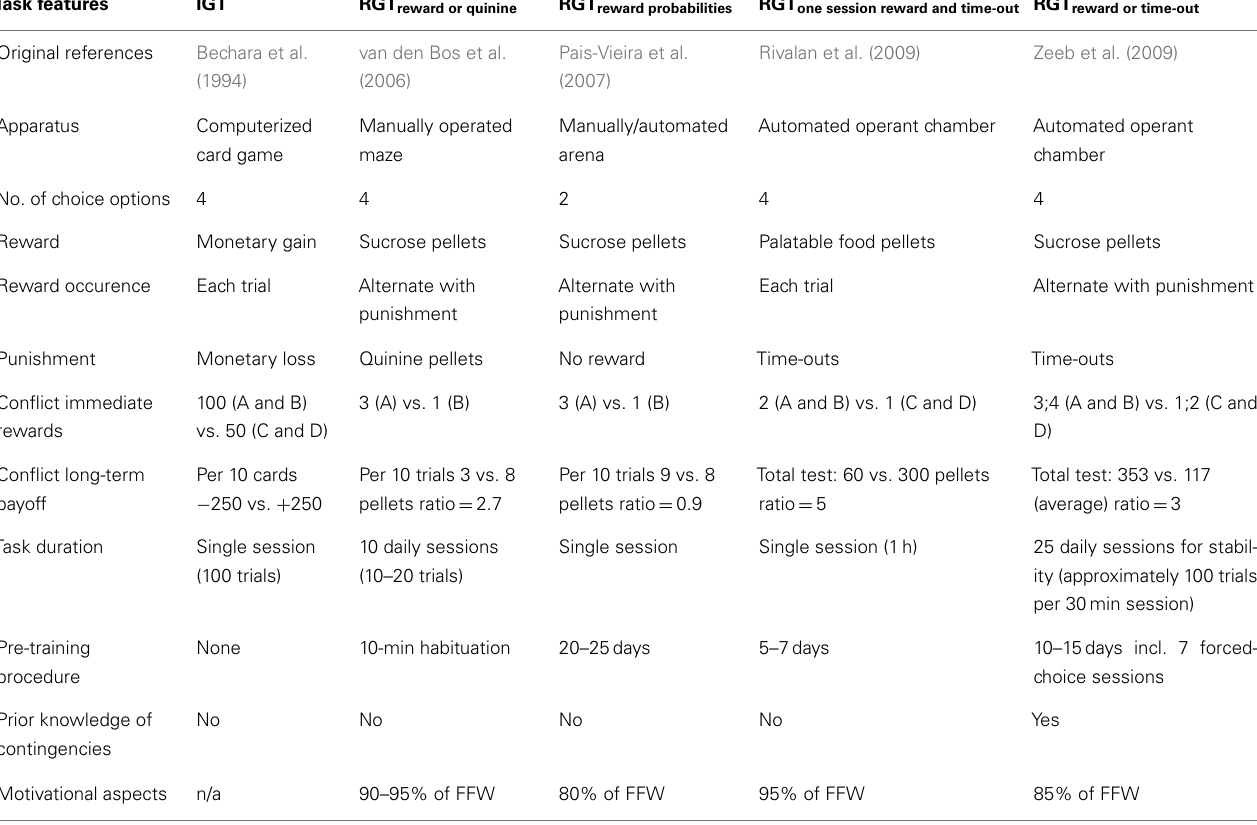
Table 1 | Main features of the human and rodent gambling